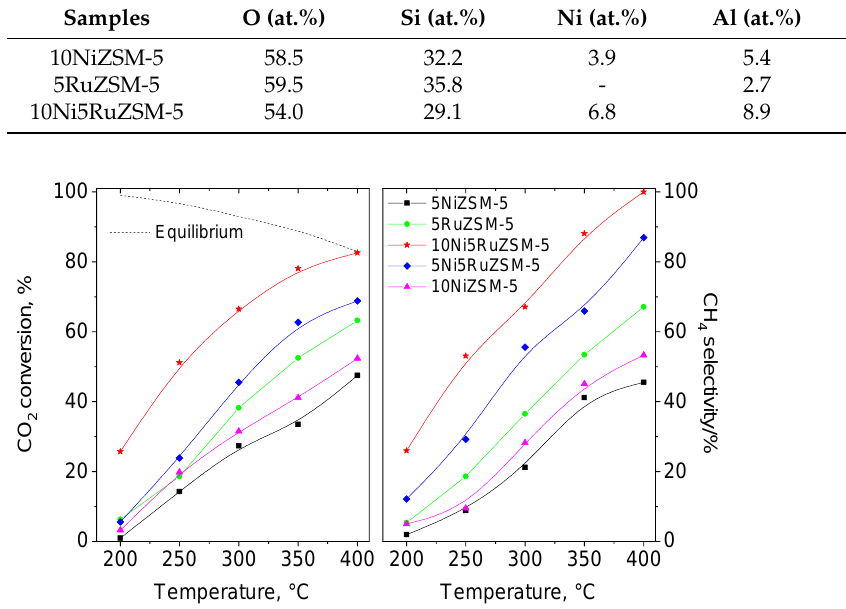
Figure 6. Catalytic activity vs. temperature for the studied catalysts (H 2 :CO 2 = 4:1; GHSV = 30,000 mL g cat − 1 h −1 ).